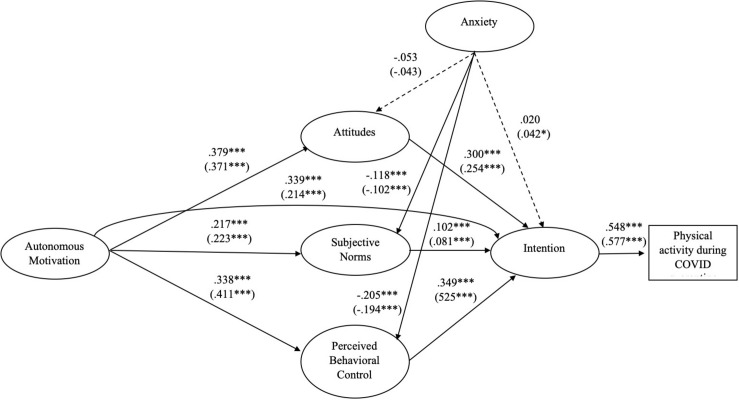
The multi-group model. Results of the structural equation model for the proposed integrated theoretical model related to the comparison between Lombardy sample and the other regions sample. Standardized path coefficients for Lombardy sample are reported in parentheses. Dashed lines indicate paths that were not statistically significant (p > 0.05). ∗∗∗p < 0.001; ∗p < 0.05.